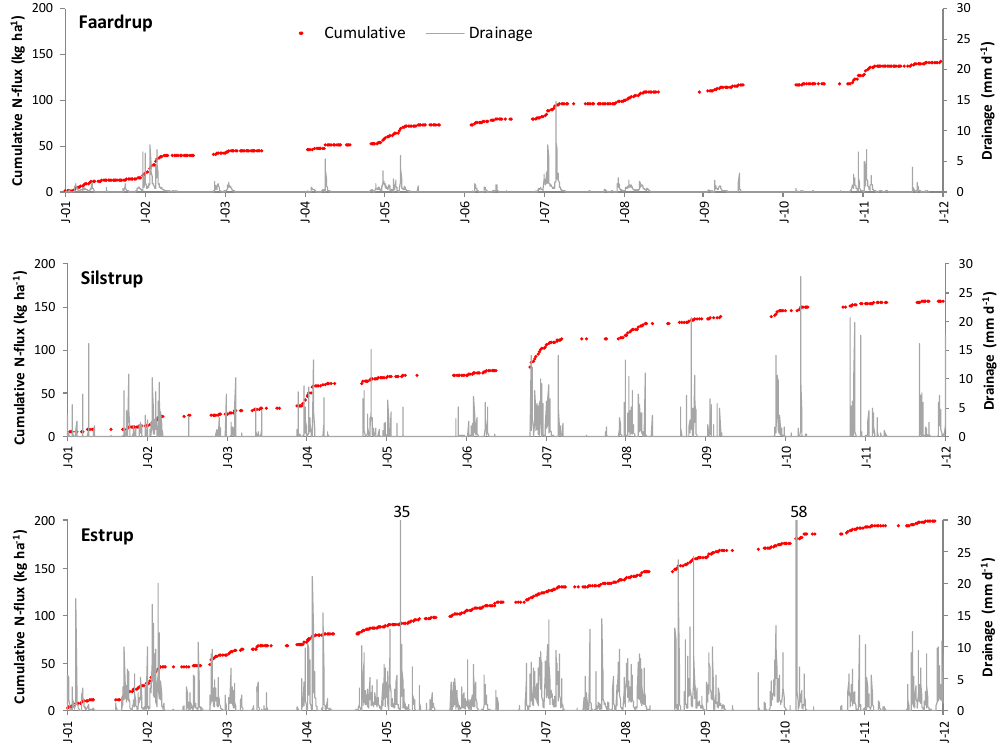
Figure 5. Cumulative nitrate-N flux and drainage for 2001–2012 at Faardrup, Silstrup and